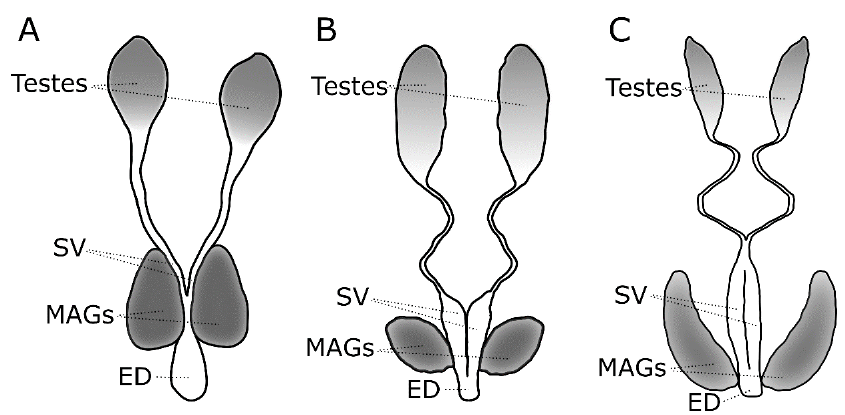
Figure 1. Morphology of the male reproductive tract in ( A ) Anopheles gambiae , ( B ) Culex pipiens and ( C ) Aedes aegypti . MAG = male accessory gland, SV = seminal vesicle, ED = ejaculatory duct.